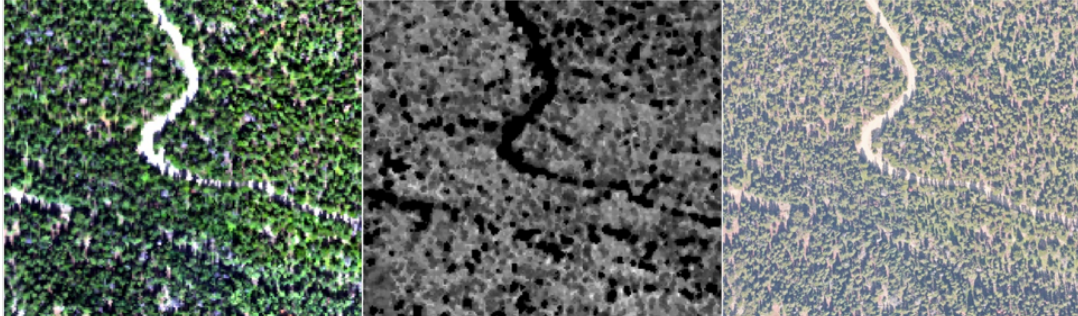
Figure 3. Comparison of raster data products from each of the three NEON Airborne Observation Platform (AOP) instruments at the Niwot Ridge Mountain Research Station site: hyperspectral true-color composite with 1 m pixel size using three of the available 426 NEON Imaging Spectrometer (NIS) bands at approximate wavelengths of 450 nm, 555 nm, and 620 nm ( left ), discrete Light Detection And Ranging (LiDAR)-derived canopy height model with 1 m pixel size, where black indicates ground and brighter pixels represent taller canopy height above ground ( center ), and digital camera RGB composite with 10 cm pixel size ( right